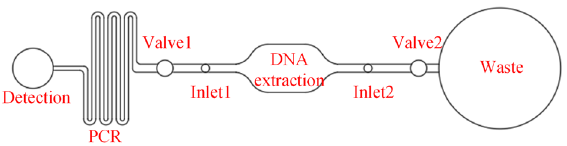
Figure 2. Structure of microfluidic chip with preset magnetic